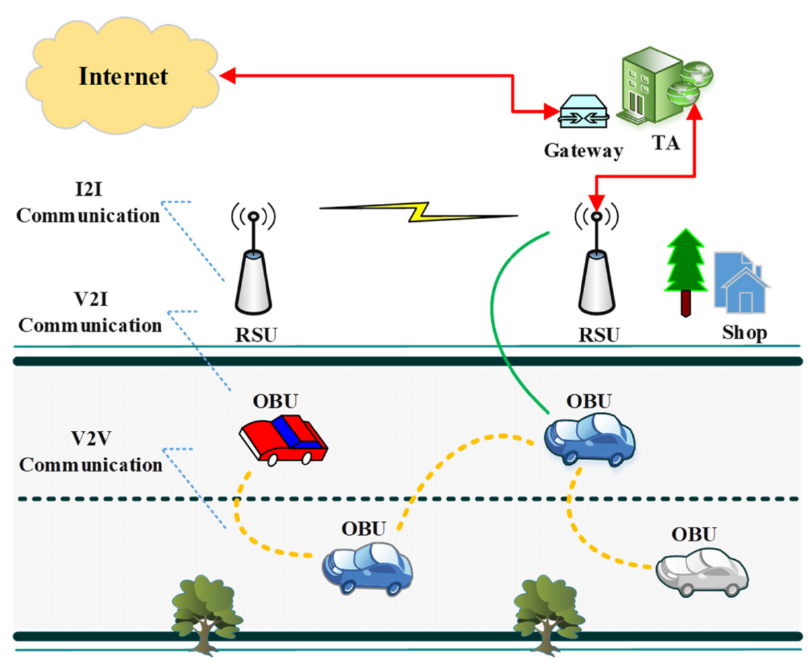
Figure 1. Generic architecture of a